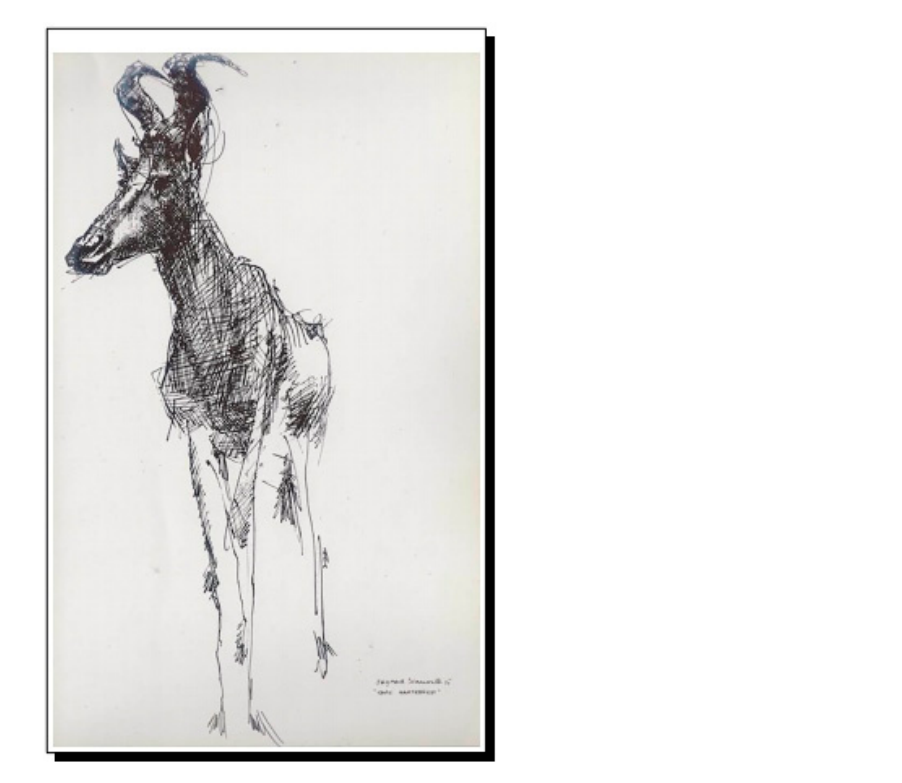
Figure 9. “Hartebeest” by Seymour Simmons III; an example of “drawing as seeing” or observing.